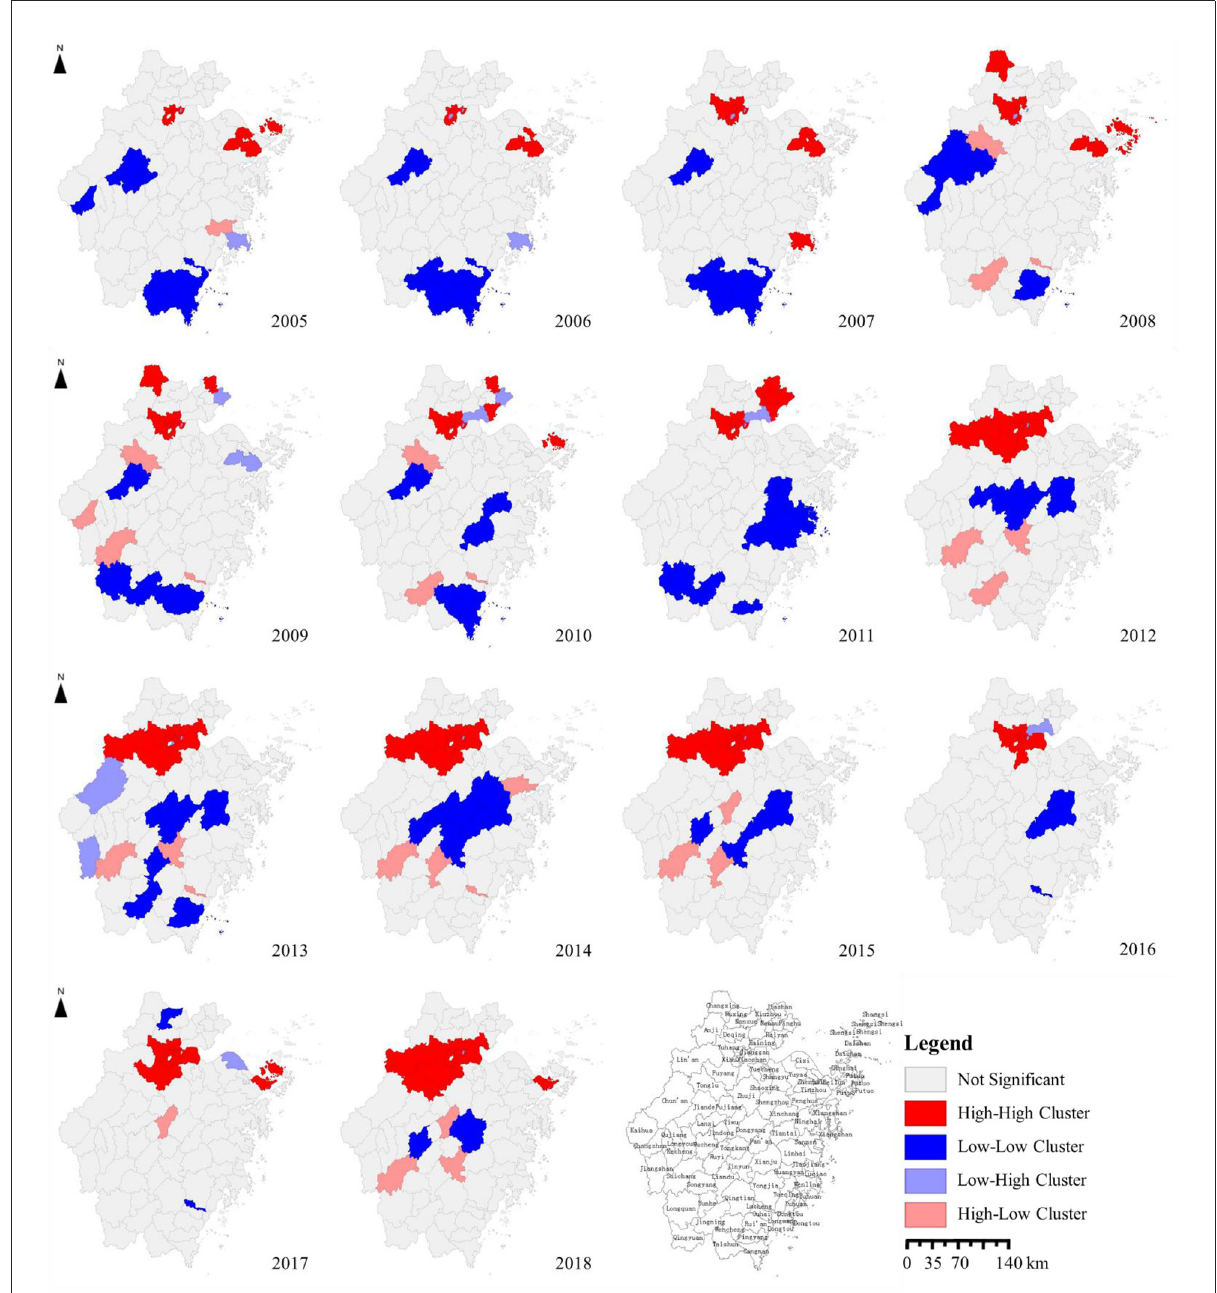
FIGURE4 Spatial autocorrelation analysis of the reported incidence of syphilis in Zhejiang Province,